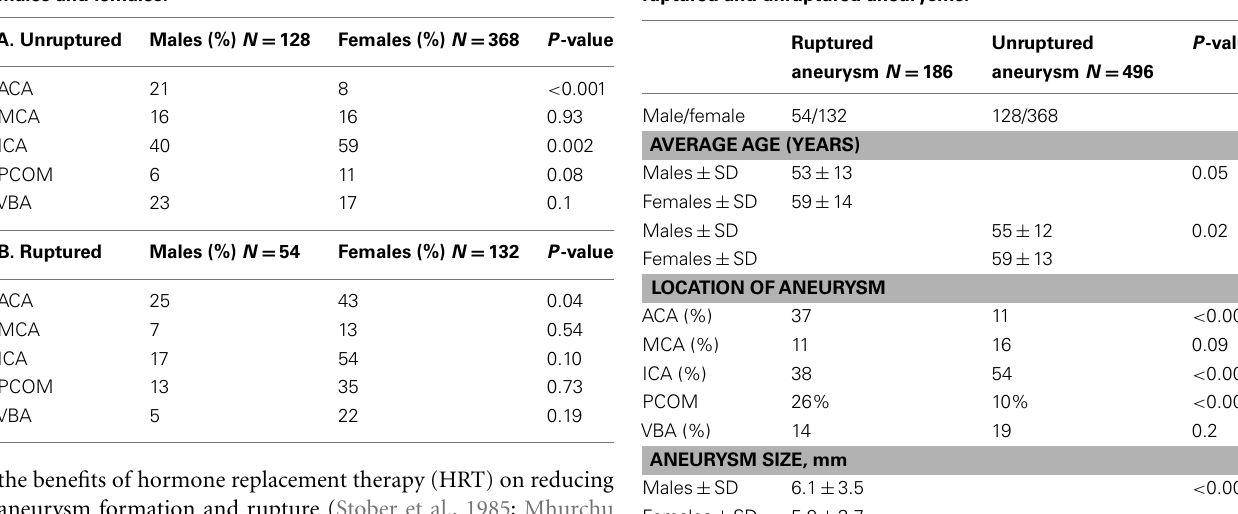
Table 2 | Location of unruptured (A) and ruptured (B) aneurysms in males and females.